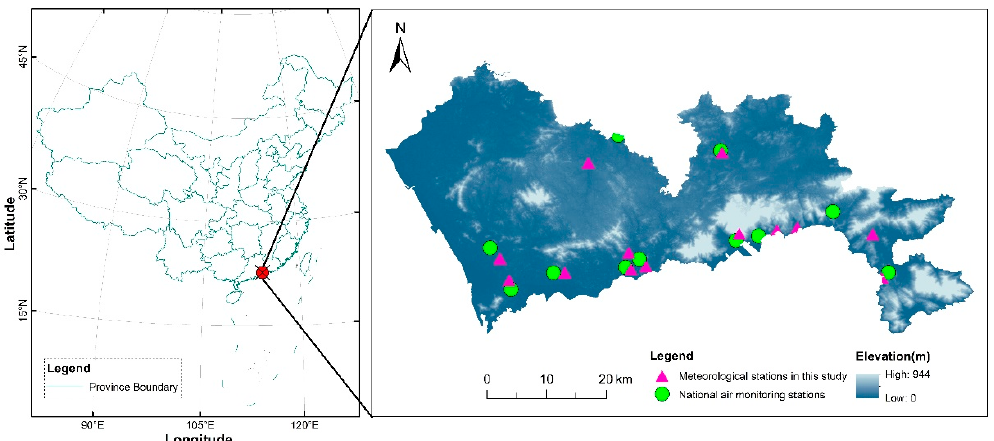
Figure 1. Location of Shenzhen City, its air monitoring stations, and the meteorological stations in this study.